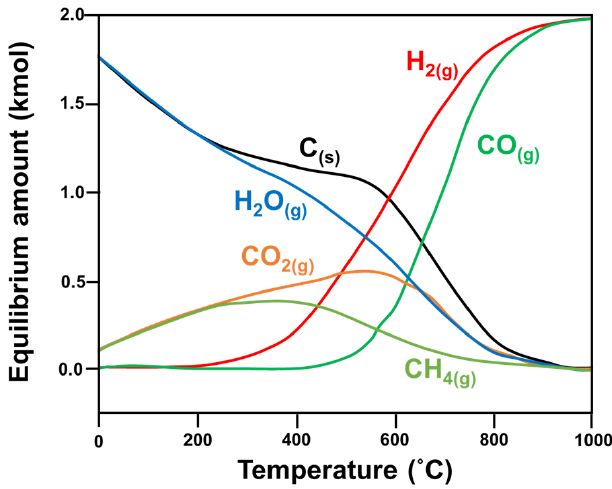
Figure 4. Equilibrium data for the DRM process. Reprinted with permission from Ref. [6]. Copyright 2016 Royal Society of Chemistry.